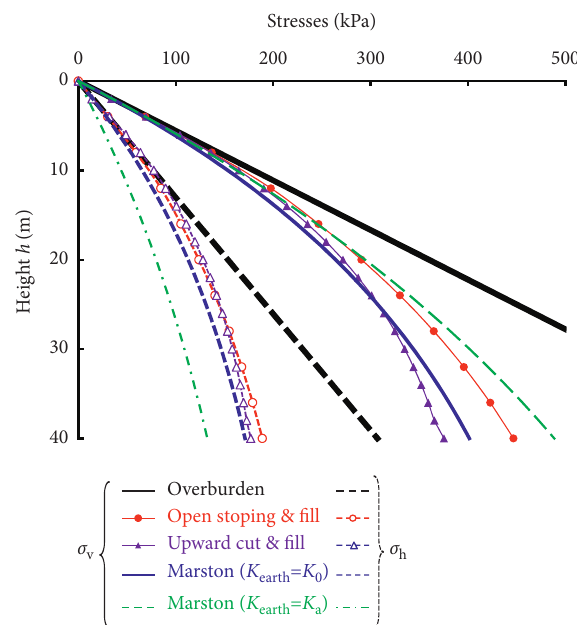
Figure 10: Comparison of vertical ( σ v ) and horizontal ( σ h ) stresses monitored at MPSB of simulated stopes in two mining methods with analytical results of the Marston